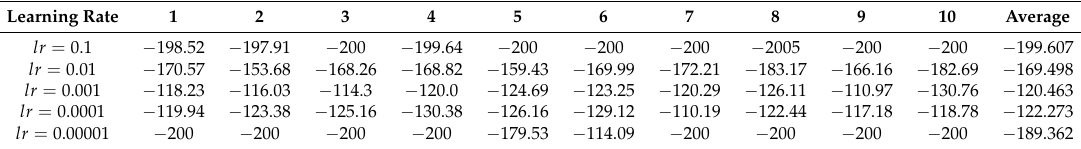
Table 2. Comparison of optimal return values obtained by different learning rates.